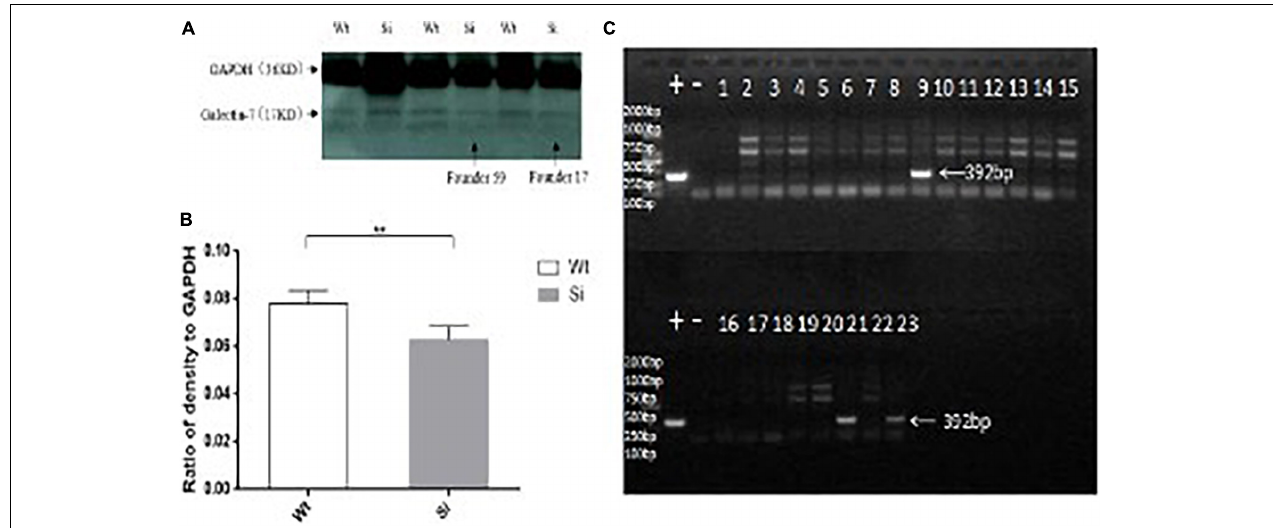
FIGURE 3 | Differential expression of the galectin-7 protein in tissues of TG mice. Panel (A) shows transgene expression at the protein level [Tg (+) positive mice in the same litter, Tg ( − ) negative controls in the same litter]. WB bands are clearly visible in TG mouse samples (Tg +) as 17 kD protein bands, with expression levels presented as means ± SD. * p < 0.01 vs. that of the Tg(–) group. Panel (B) shows the expression of galectin-7 protein expression (as determined via WB) in knockdown mice and wild-type BALB/c mice, respectively. WT (BALB/c mice), Si (galectin-7 knockdown BALB/c mice). Protein bands with expression levels presented as means ± SD. * p < 0.05 vs. WT group. Panel (C) shows a positive control PCR experiment diagram of the interference sequence, and 392 bp is the product of the interfering sequence and interfering sequence vector amplification. *P < 0.05, **P < 0.01, ***P < 0.001. One asterisks signify less than 0.05, indicating a difference, statistically